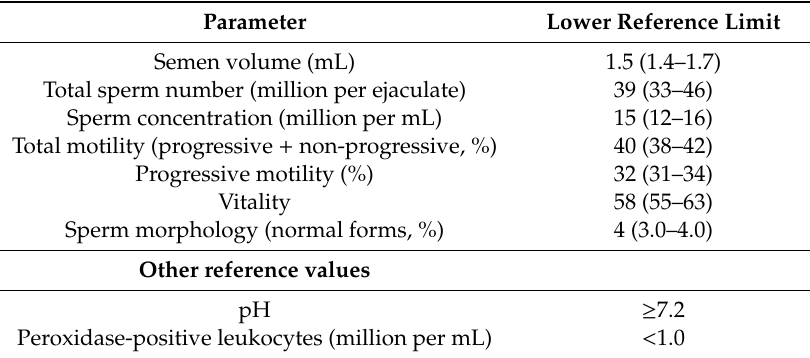
Table 4. Lower reference limits (5th percentiles and their 95% confidence intervals) for semen parameters